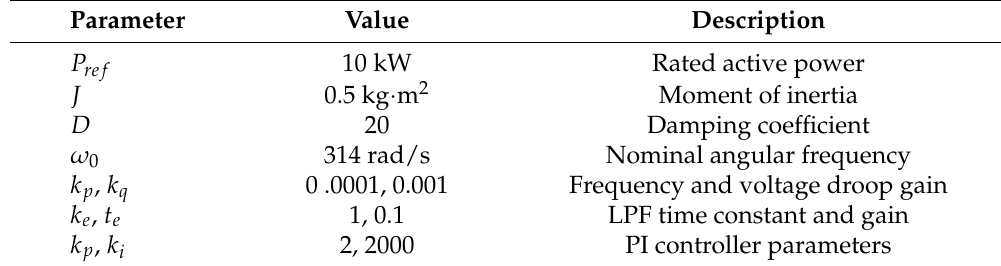
Table 2. The parameters of the VSG